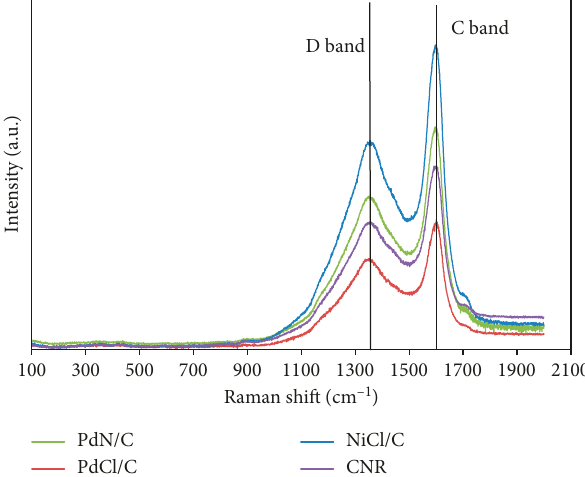
Figure 3: Raman spectroscopy for PdN/C, PdCl/C, and NiCl/C catalysts.